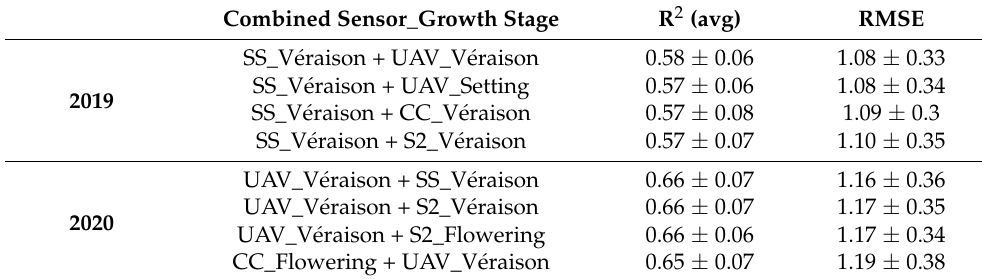
Table 3. Selected best performed R 2 per year for combined sensors and growth stages using AutoML to evaluate their performance in assessing the wine grapes quality characteristics (legend as for Table